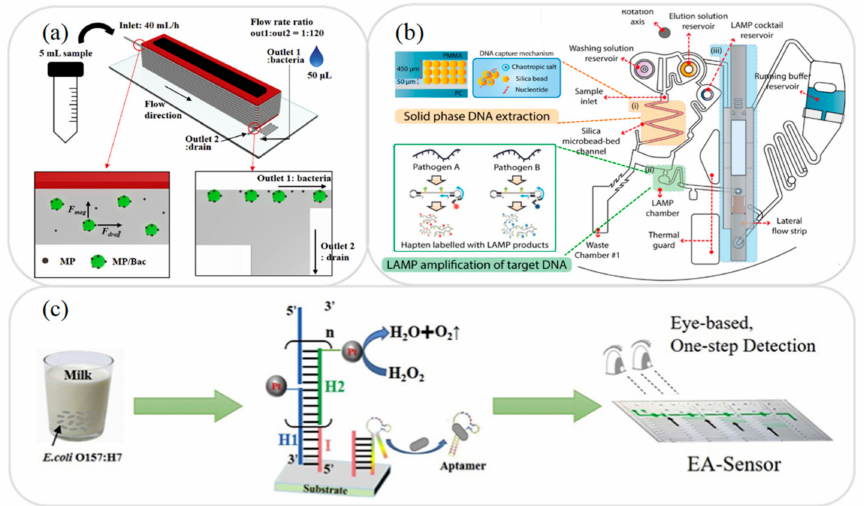
Figure 1. ( a ) Schematic illustration showing working principle of magnetophoresis-based microflu- idic device for sample separation and concentration during pretreatment process. Reprinted with permission from ref. [36]. Copyright 2020 Elsevier. ( b ) Schematic illustration showing working principle of extraction and amplification of DNA on microfluidic device. Reprinted with permission from ref. [39]. Copyright 2017 Elsevier. ( c ) Schematic illustration showing HCR amplification of bacteria on microfluidic device. Reprinted with permission from ref. [47]. Copyright 2020